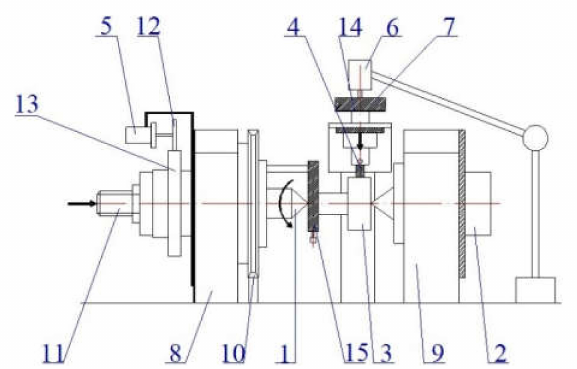
Figure 3. A scheme of a testing device TriboTester (developed by the authors): 1—sliding tip of the driving shaft; 2—backstop tip; 3—friction mating part; 4—testing specimen; 5—dynamometric revolution indicator; 6—scanner TESA; 7—pressure balance; 8—driving shaft arrangement; 9— backstop shaft arrangement; 10—drive pulley; 11—spacer bolt of the adjustable tip; 12—speedometer gear; 13—speedometer gear; 14—adjustable device of testing specimen; 15—catch